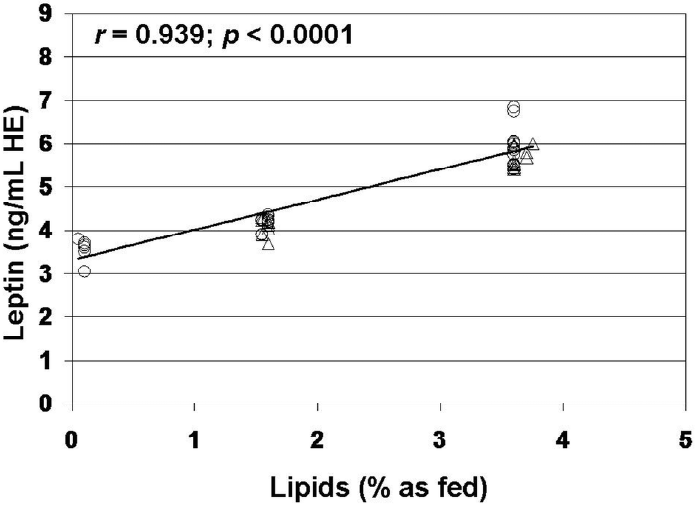
Figure 3. Analysis of correlation between leptin and lipid content of commercial milks. Data on leptin are expressed as human equivalent (HE). Circles are used for UHT milk samples. Triangles are used for pasteurized milk